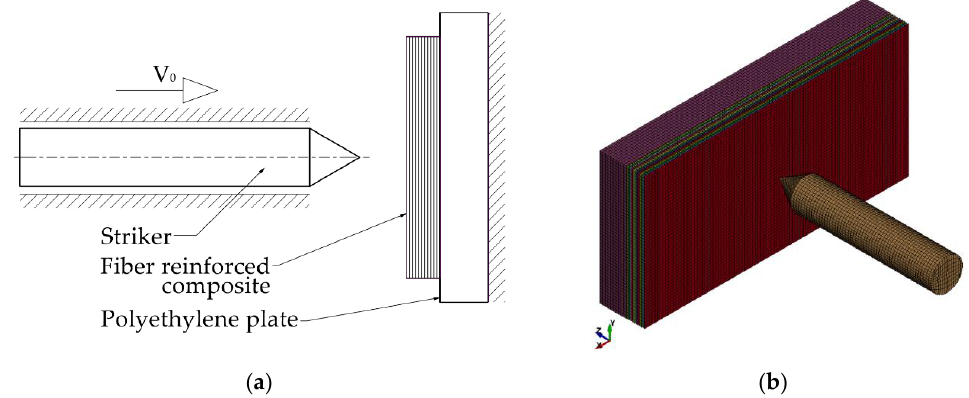
Figure 6. Numerical research: ( a ) schematic diagram, ( b ) physical model.